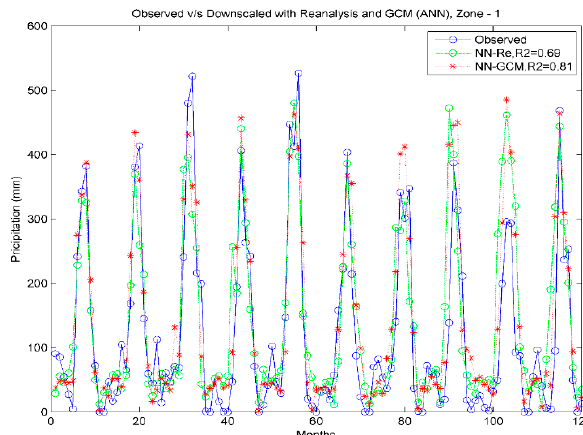
Figure 6. Simulated v/s observed zonal averaged precipitation with CMCC-CMS GCM by Re-Obs and the GCM-Obs models for zone-1. Notations—NN-Re and NN-GCM represents precipitation downscaled using ANN method with Re-Obs and the GCM-Obs models, respectively. R 2 is the coefficient of determination between observed and downscaled precipitation.